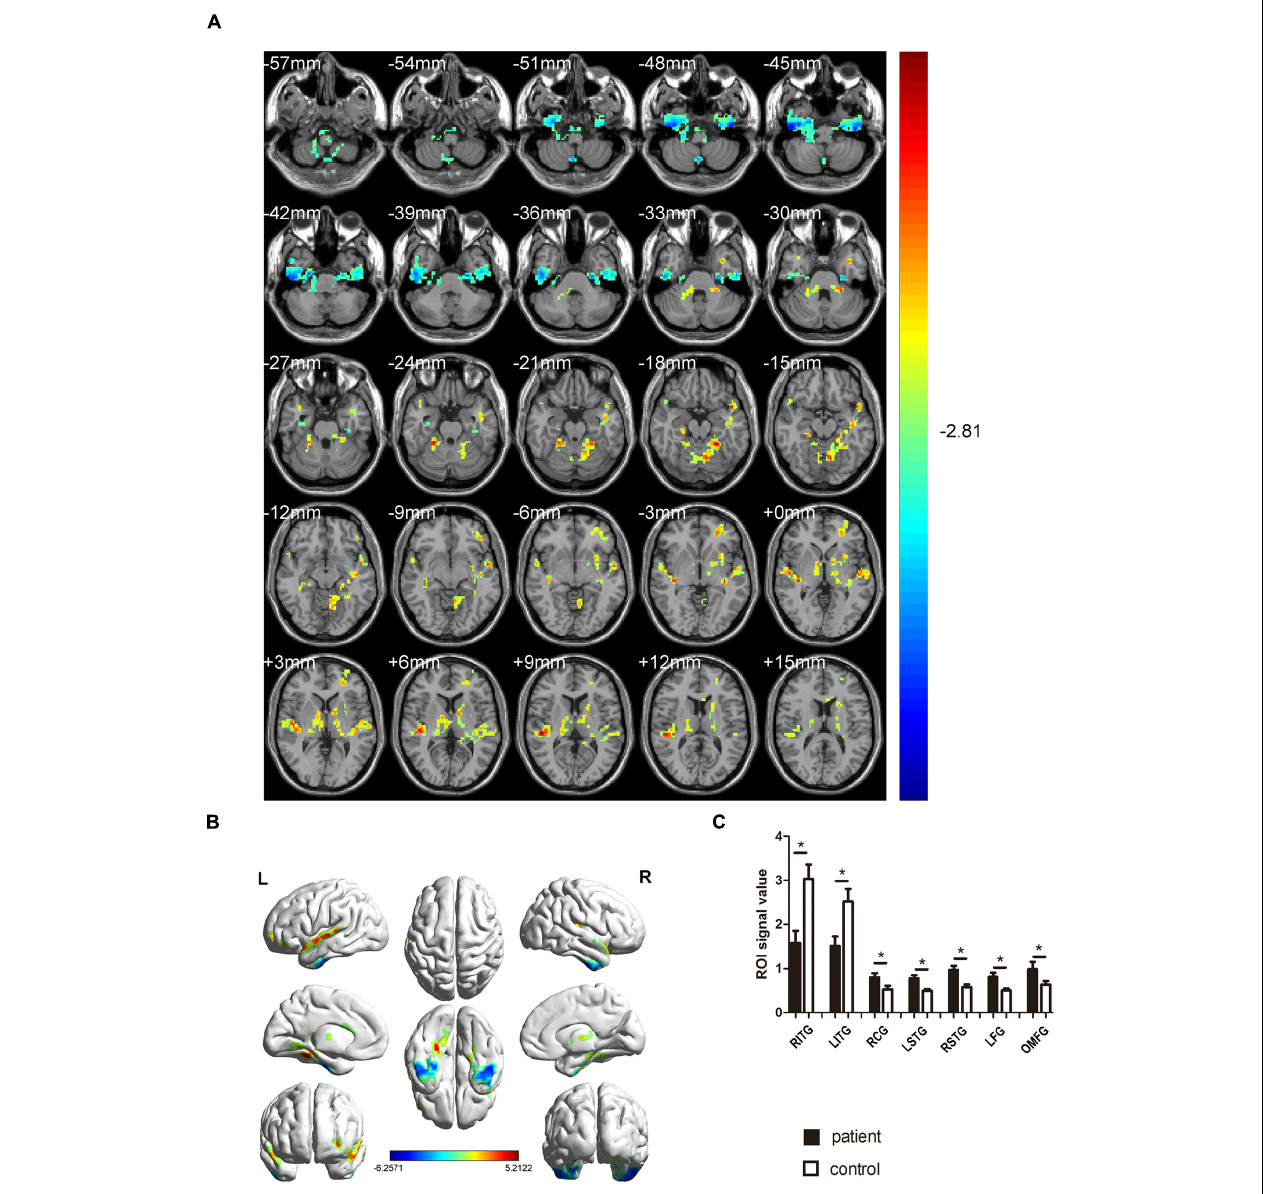
FIGURE 2 | Comparison of ReHo values in MCI and HC groups. (A) Differences in ReHo were found in RCG, LSTG, RSTG, LFG, and OMFG, RITG, and LITG. (B) The stereoscopic form of the cerebrum. The red area indicates an increase in ReHo value; the blue indicates a decrease in ReHo value. (GRF correction, the cluster-level: P < 0.05; two-tailed, with voxel level P < 0.005). (C) The Mean ReHo value between MCIs and control group. ReHo, regional homogeneity; MCI, mild cognitive impairment; HC, healthy controls. * P < 0.05 Independent t-tests comparing two groups.